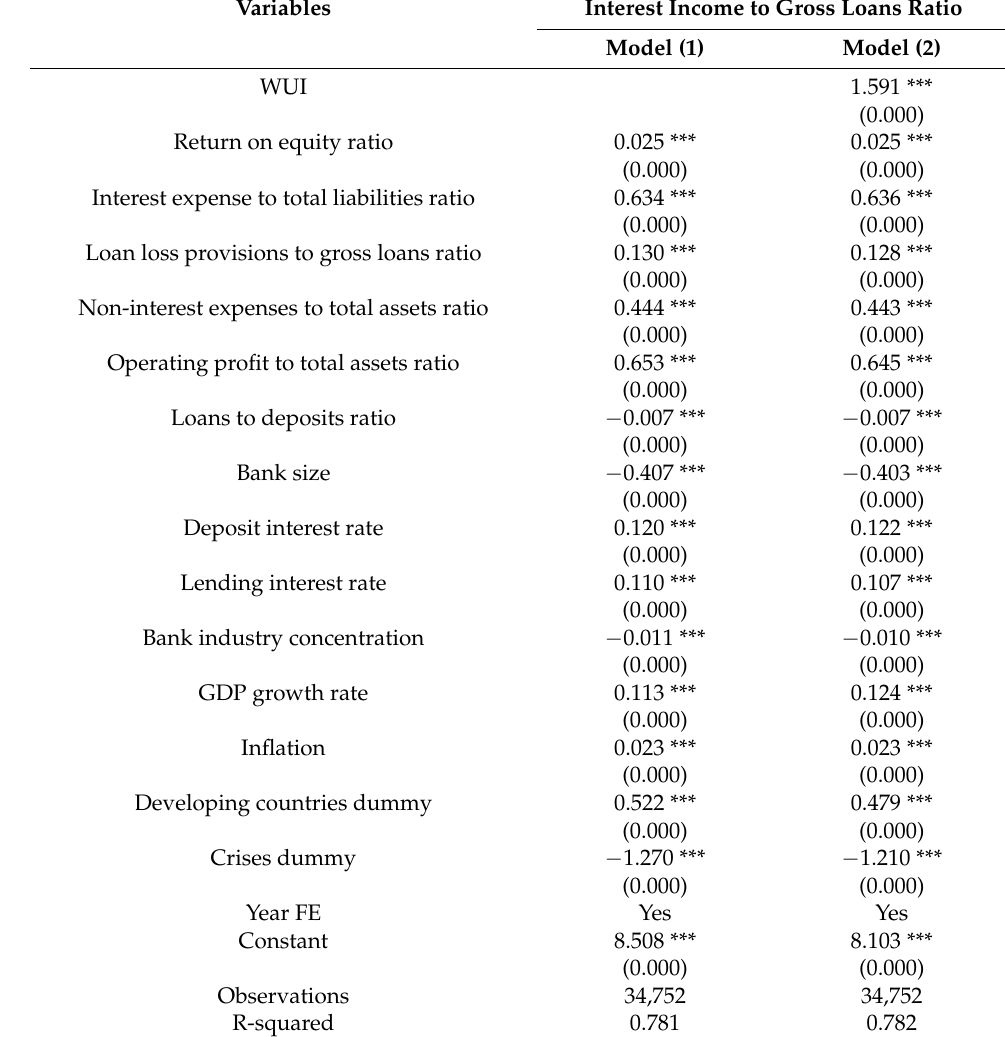
Table 5. Economic and political uncertainty and bank loan pricing: Main specification. This table reports results regarding the impact of economic uncertainty on bank loan interest rates. Bank loan interest rate is measured with annual ‘interest income to gross loans ratio’ and is dependent variable in all models. WUI is world uncertainty index of Ahir et al. (2018), which represents economic uncertainty. Others are control variables. Detailed definitions of variables are given in Table 2. The results are estimated with pooled OLS estimator using heteroskedasticity robust standard errors. P -values are given in parenthesis. *** represents statistical significance at 1%